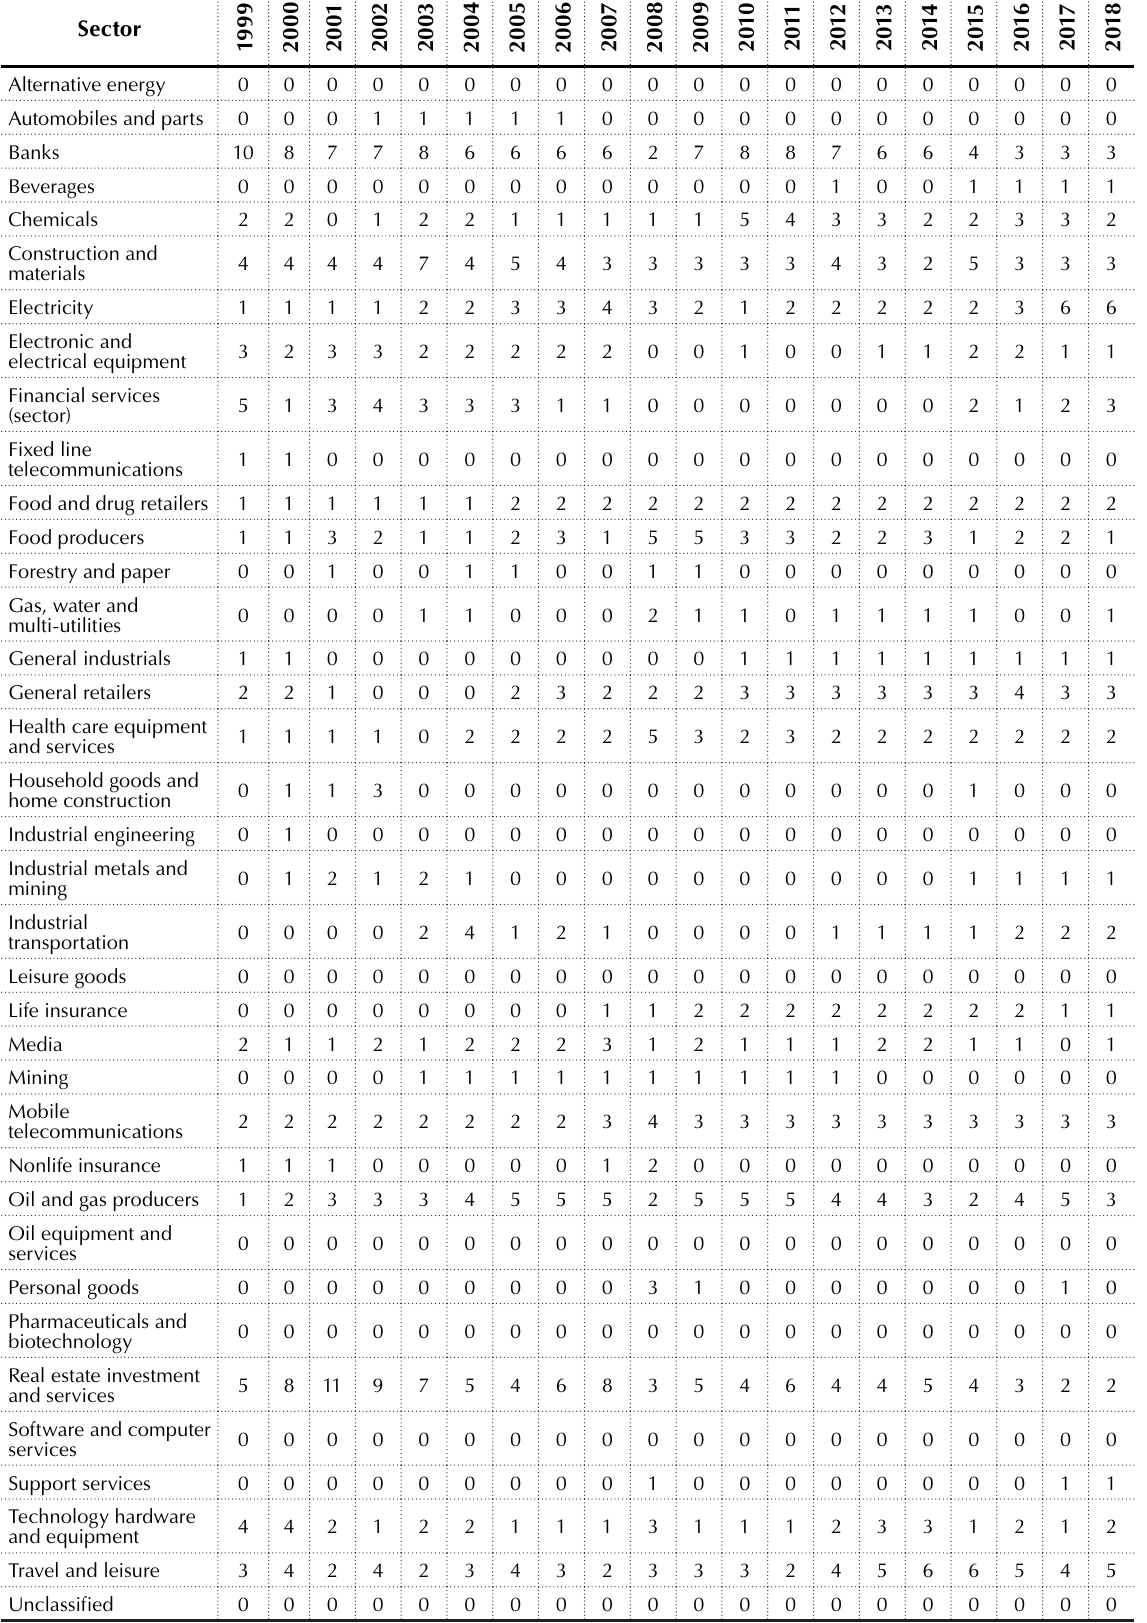
Table 2. Industrial sectors of the top 50 MVA stocks during